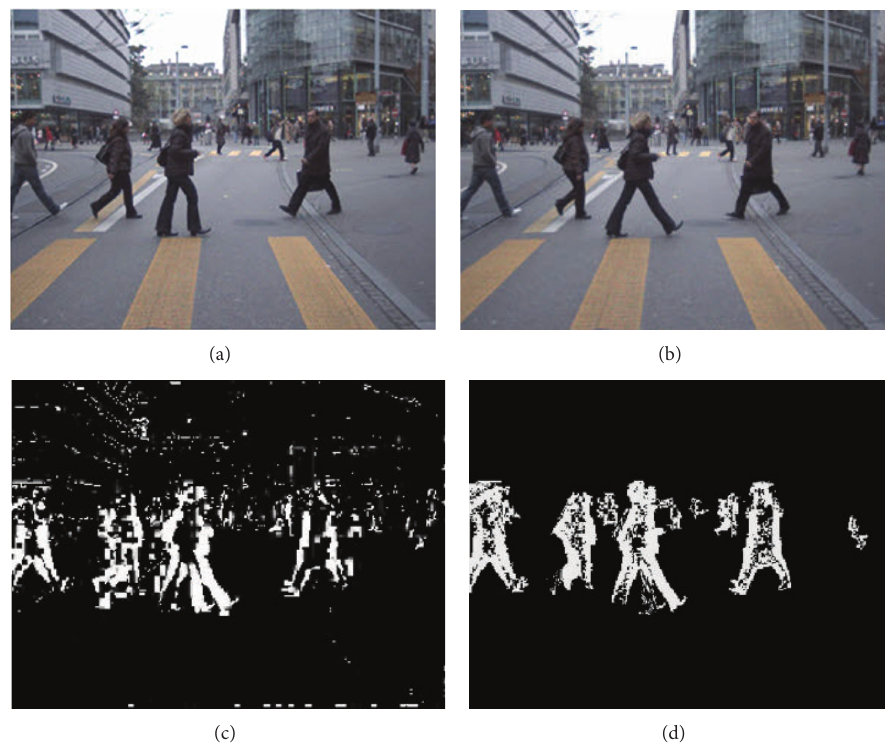
Figure 3: From two consecutive images (a) and (b), we applied frame difference (c) and comparing when we applied frame difference with egomotion compensated